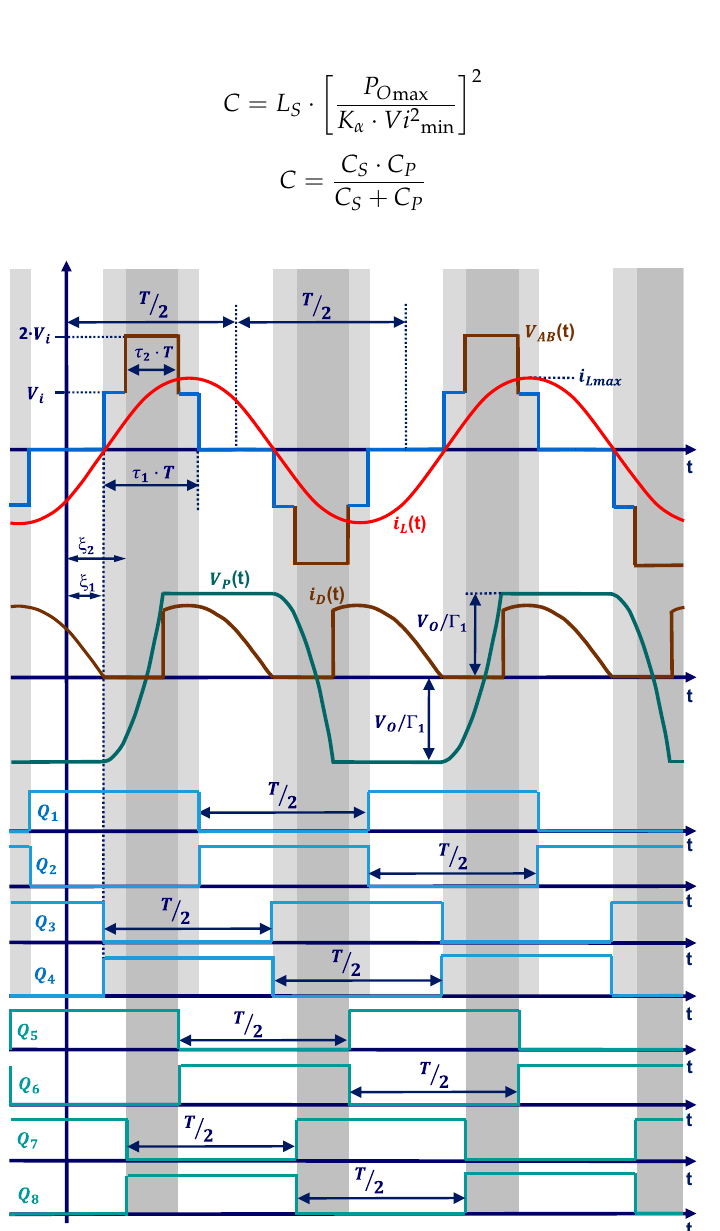
Figure 4. Voltage ( V AB ) and current ( i L ) at the input of the resonant tank. ξ 1 , ξ 2 represent the gate delay signals.